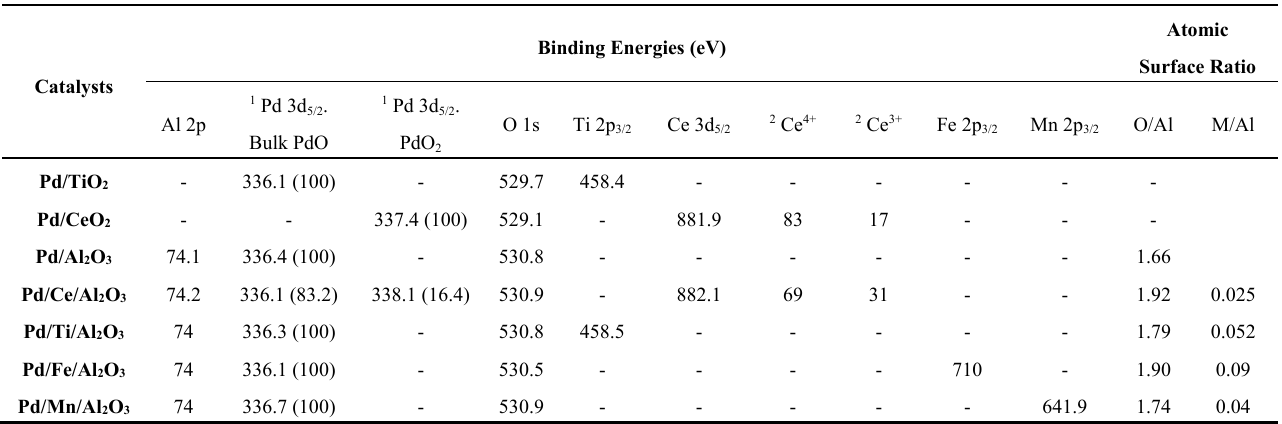
Binding Energies (eV)